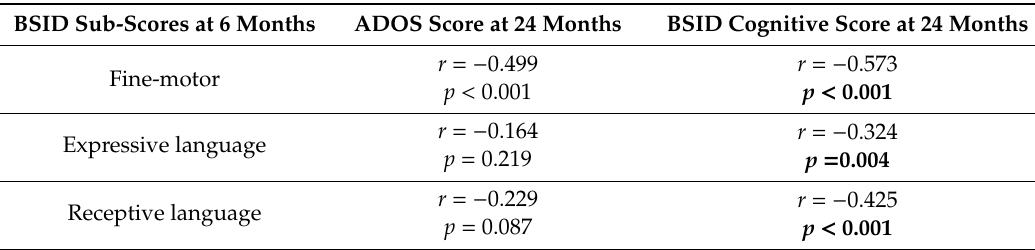
r = − 0.324 p = 0.004 r = − 0.425 p <